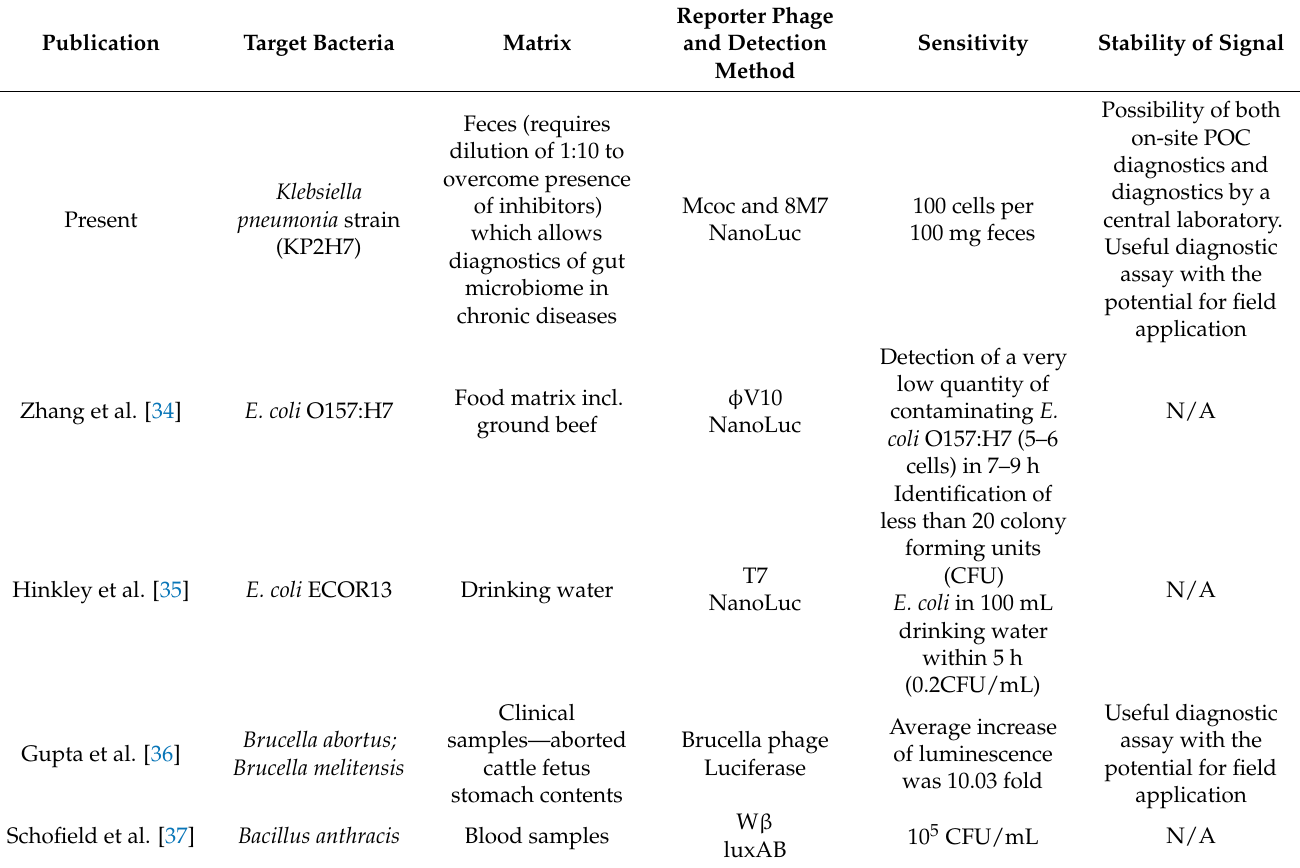
Table 1. Reporter phages described in the literature compared with the here-described